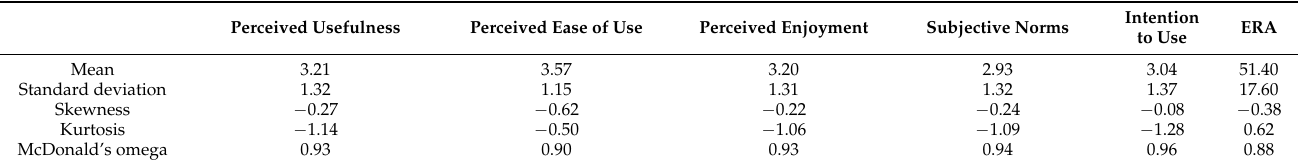
Table 1. Descriptive statistics, skewness, kurtosis, and internal